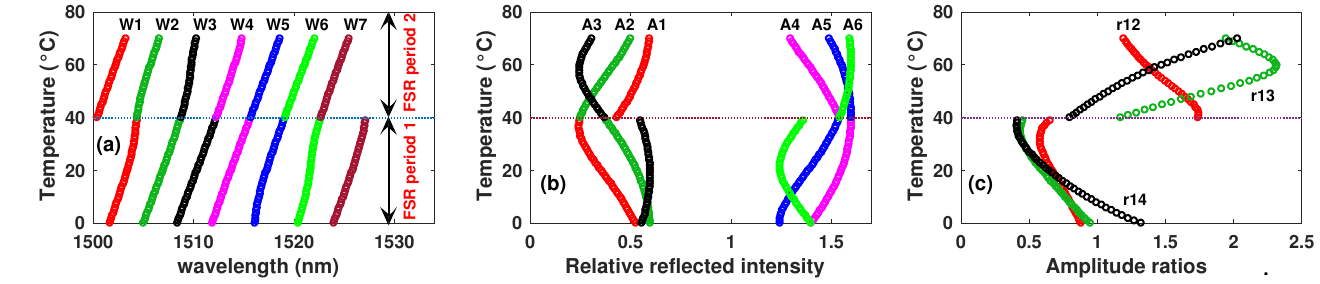
Figure 4. Simulated ( a ) peak wavelength positions, ( b ) peak amplitudes ( c ) amplitudes ratios as a function of temperature of sensor 1. In ( b ), A4–A6 were shifted 1 unit to the right for clarity purposes.